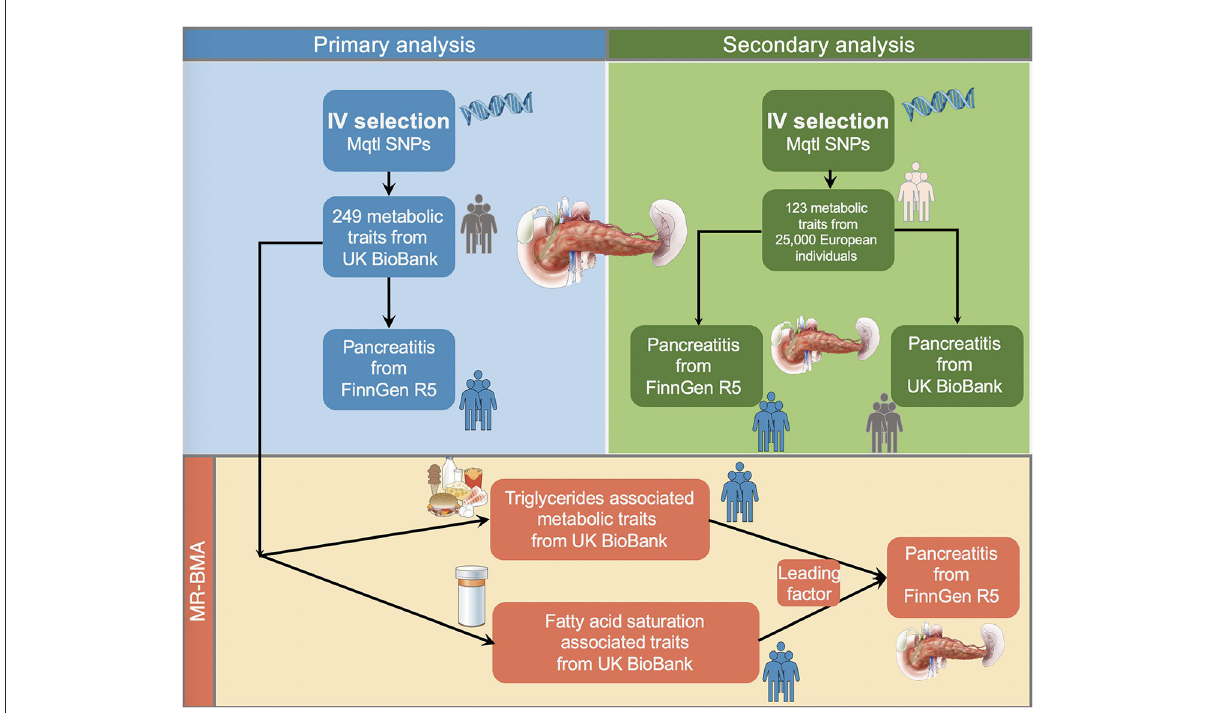
FIGURE1 Schematic illustration of the study design. We performed the primary and secondary analysis using two distinct metabolites quantitative trait datasets on different pancreatitis datasets in the two-sample MR fashion. Next, we selected the metabolites with large numbers of shared single nucleotide polymorphisms for the Bayesian model averaging analyses to prioritize the predominating risk factor leading to susceptibility of pancreatitis. IVs, instrumental variables; Mqtl, metabolites quantitative trait